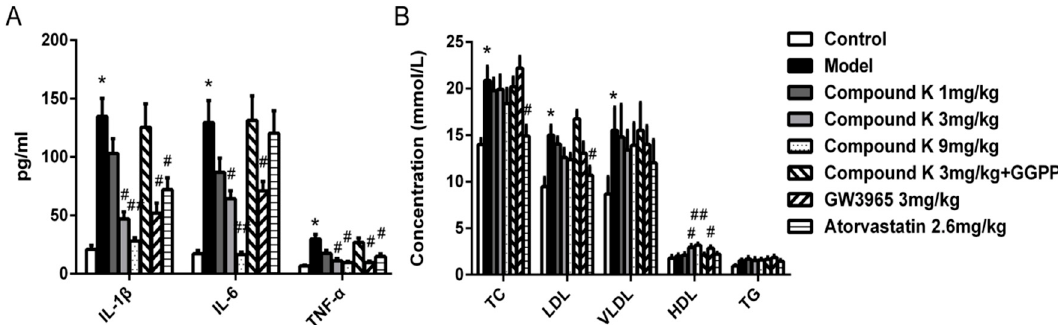
Figure 2. Effects of compound K on serous lipid profile and inflammatory cytokines in apoE − / − mice. Serous total cholesterol (TC), low density lipoprotein cholesterol (LDL), very low density lipoprotein cholesterol (VLDL), high density lipoprotein cholesterol (HDL) concentrations and triglyceride (TG) in apoE − / − mice treated with different concentrations of compound K were measured using Olympus AU-2700 automatic biochemical analyzer ( A ); Levels of serum IL-1 β , IL-6 and TNF- α were detected by Mcytomag-70K-3 Mouse Cytokine/Chemokine Magnetic Bead Panel ( B ). Data are presented as mean ± SEM ( n = 6) and analysed by ANOVA with Dunnett’s post-hoc analysis. * p < 0.05 vs. control; # p < 0.05 vs. model; ## p < 0.01 vs. model.